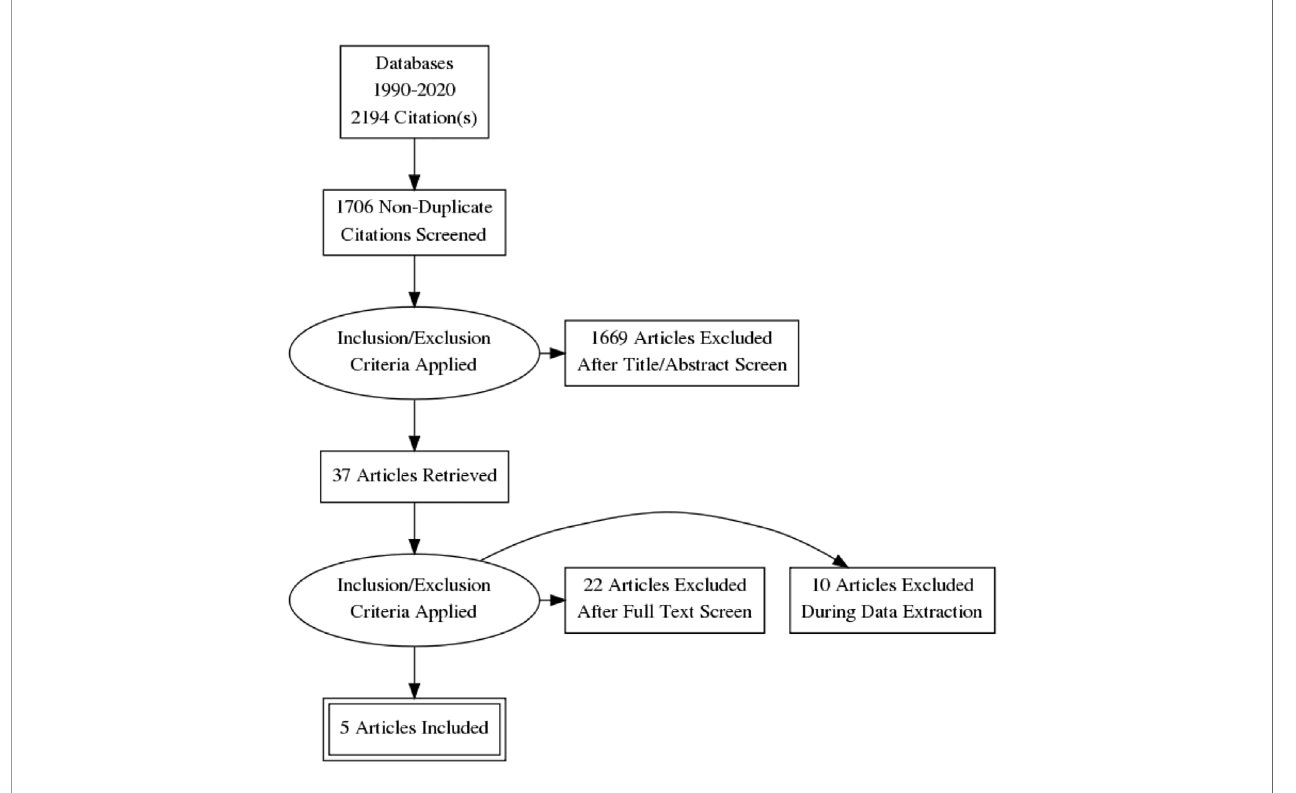
FIGURE 3 | Flow diagram of study selection.